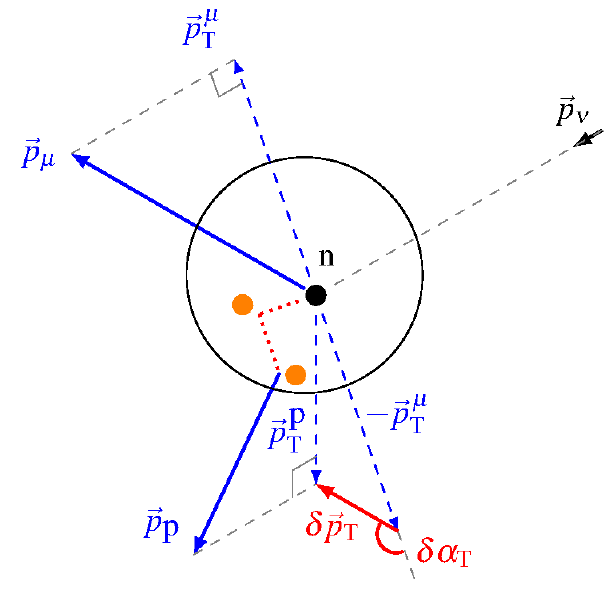
FIG. 1: Schematic definition of the transverse kinematics